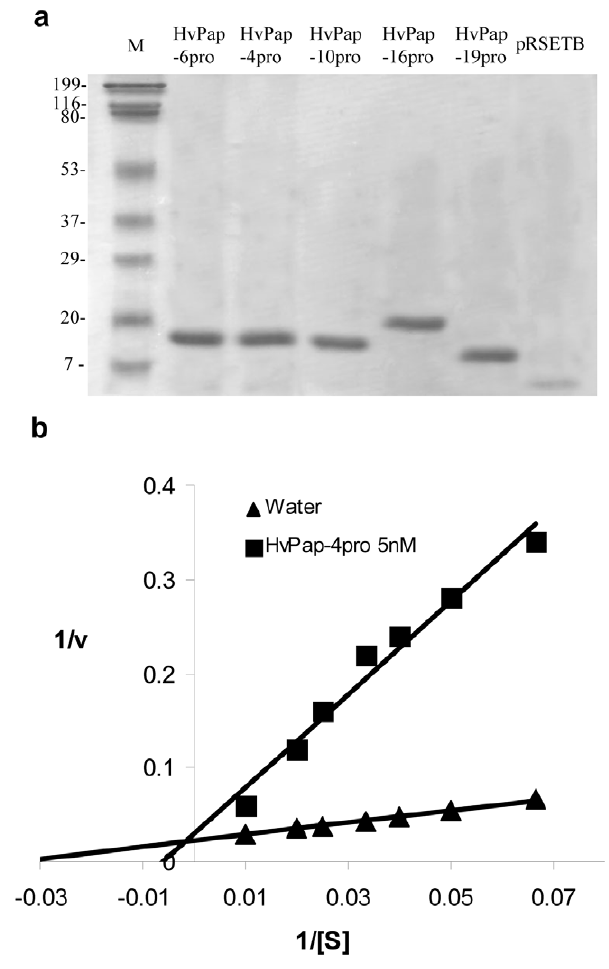
Figure 1. Purification and inhibitory mechanism of propep- tides. A. Purification of the recombinant HvPap propeptides from E. coli cultures by SDS-PAGE. Five m g of each protein were loaded. Five m g of an extract of pRSETB without insert were used as a control of protein purity. The gel was stained with Coomassie Brillant Blue G. M: molecular markers (KD). B . Example of Lineweaver-Burk plot. HvPap-10 compet- itive inhibition in the presence of HvPap-4pro. Water was used as a control.